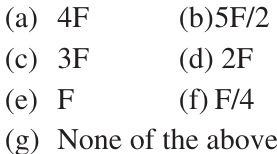
original BEMA. Table X lists the item parameters for BEMA, HBEMA1, HBEMA2, and CSEM obtained in this